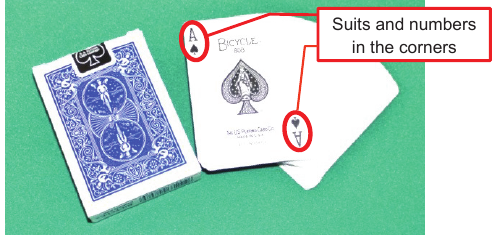
Figure 2. Suits and numbers used in machine learning with Haar-like